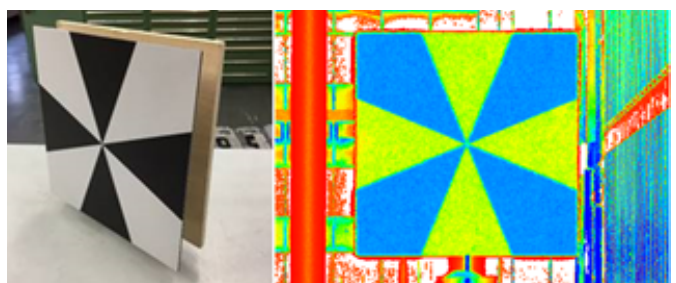
Figure 13. Left : photo of the newly developed target with 8-fold pattern (BOTA8, target t 6), right : scan of the BOTA8 (target t 6).